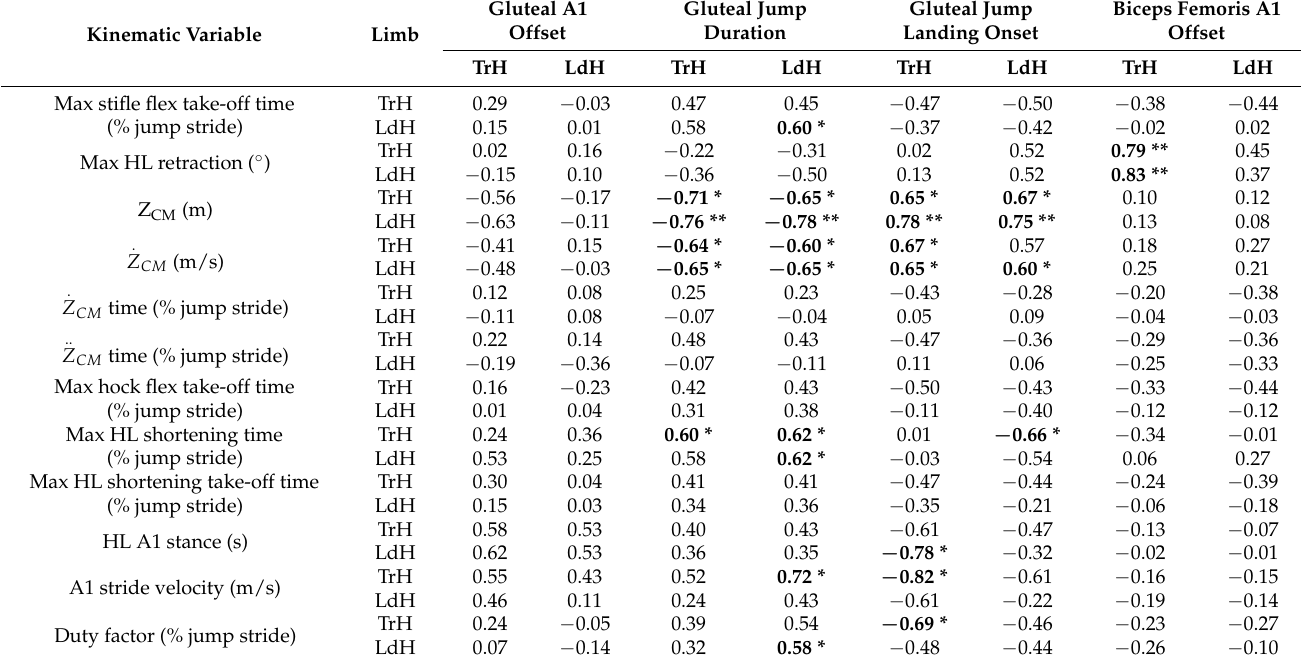
Table 3. Correlations between kinematic and sEMG activity timing variables where significant ( p < 0.05) between-group differences were observed. Pearson correlation coefficients (r) are presented for each comparison. Significant ( p < 0.05) correlations are denoted by bold